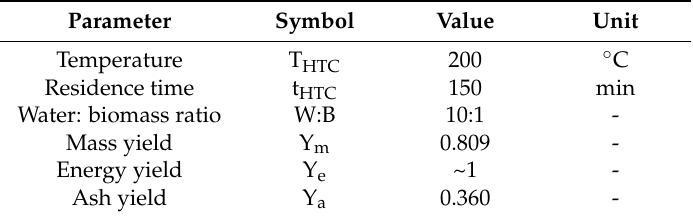
Table 2. Characterization of the HTC process.